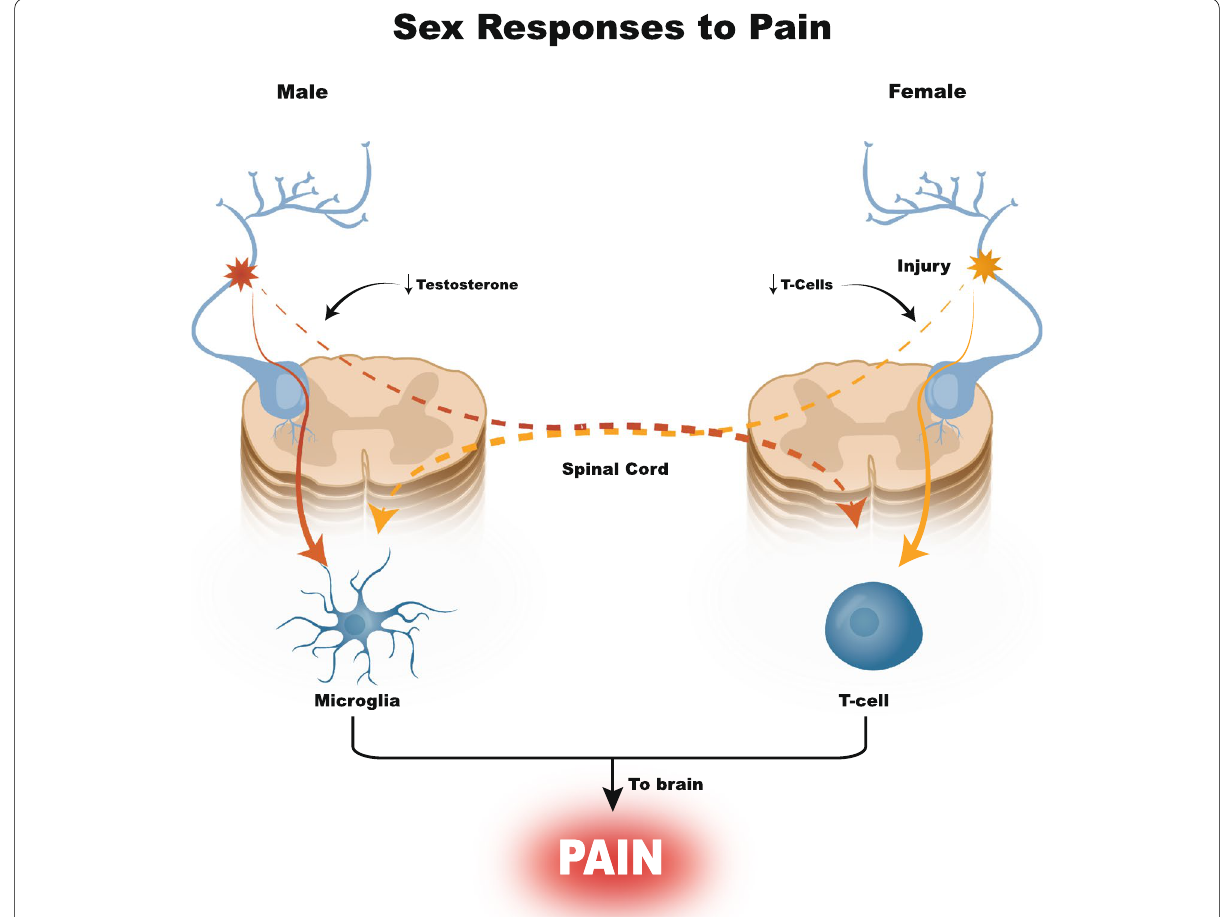
Fig. 1 Sex-based differences in pain pathways. In the male model, microglia are activated to transmit pain, mediated by testosterone levels, while in the female model, the pain pathway is T-cell mediated. If a male has low testosterone levels, the pain pathway switches to the T-cell mediated pathway. Conversely, if a female takes exogenous testosterone, or if she has low T-cell levels, the pain pathway will switch to the microglia